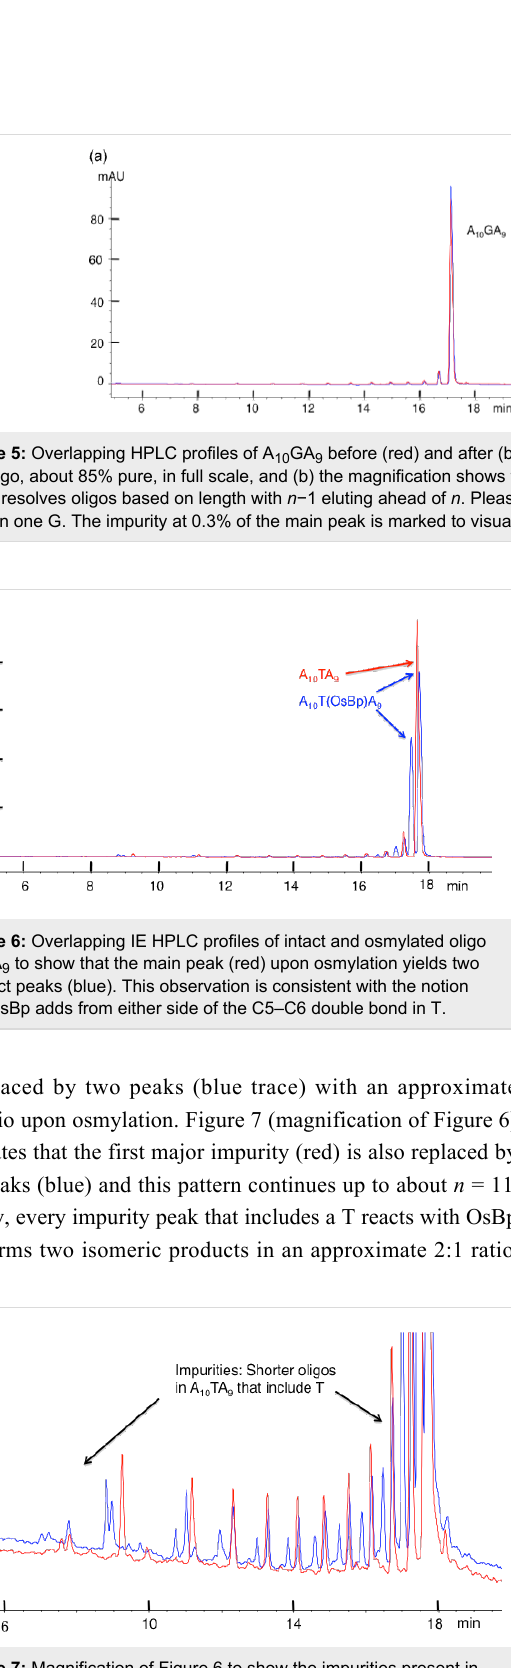
Figure 7: Magnification of Figure 6 to show the impurities present in A 10 TA 9 and the fact that each oligo (red) that contains a T forms two isomeric product peaks (blue) in an approximate 2:1 ratio. Note that by HPLC the major isomer elutes later than the minor isomer, whereas by CE the major isomer migrates ahead of the minor isomer.